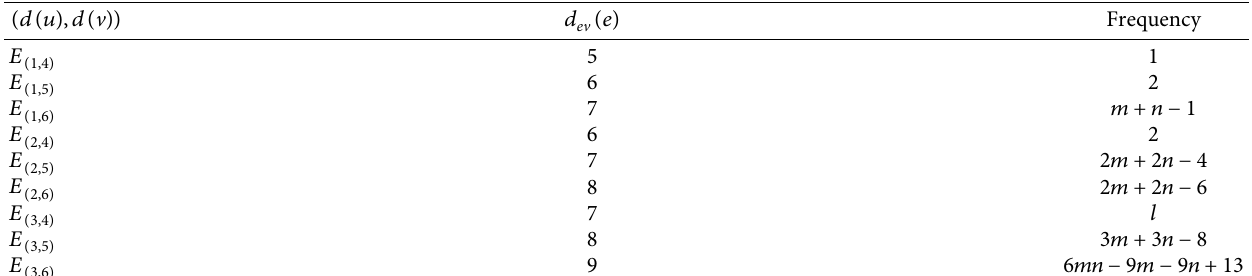
Figure 1: Molecular structure of vanadium carbide for m � 5 and n � 5. Table 2: Ev-degrees of edges of vanadium